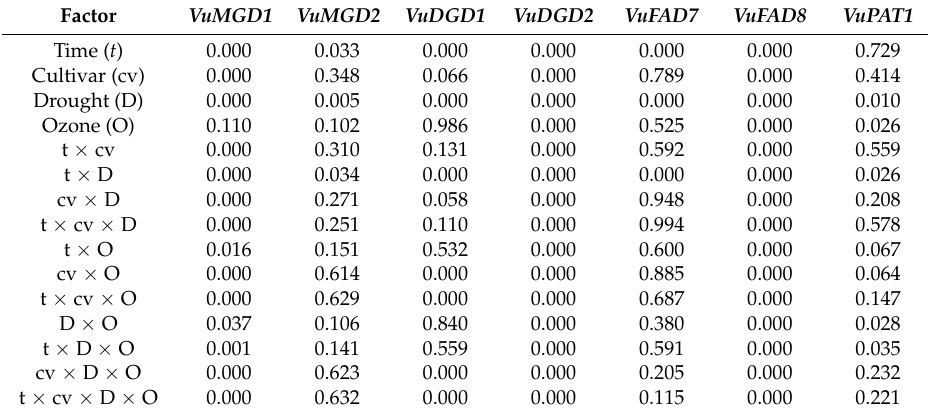
Table A4. Analysis of variance (ANOVA) of gene expression data. The displayed results are p -values for individual factors (time, cultivar, drought and ozone) and their multiple interactions. Values in bold are significant at α = 0.05. VuMGD1 , type 1 monogalactosyl-diacylglycerol synthase; VuMGD2 ,